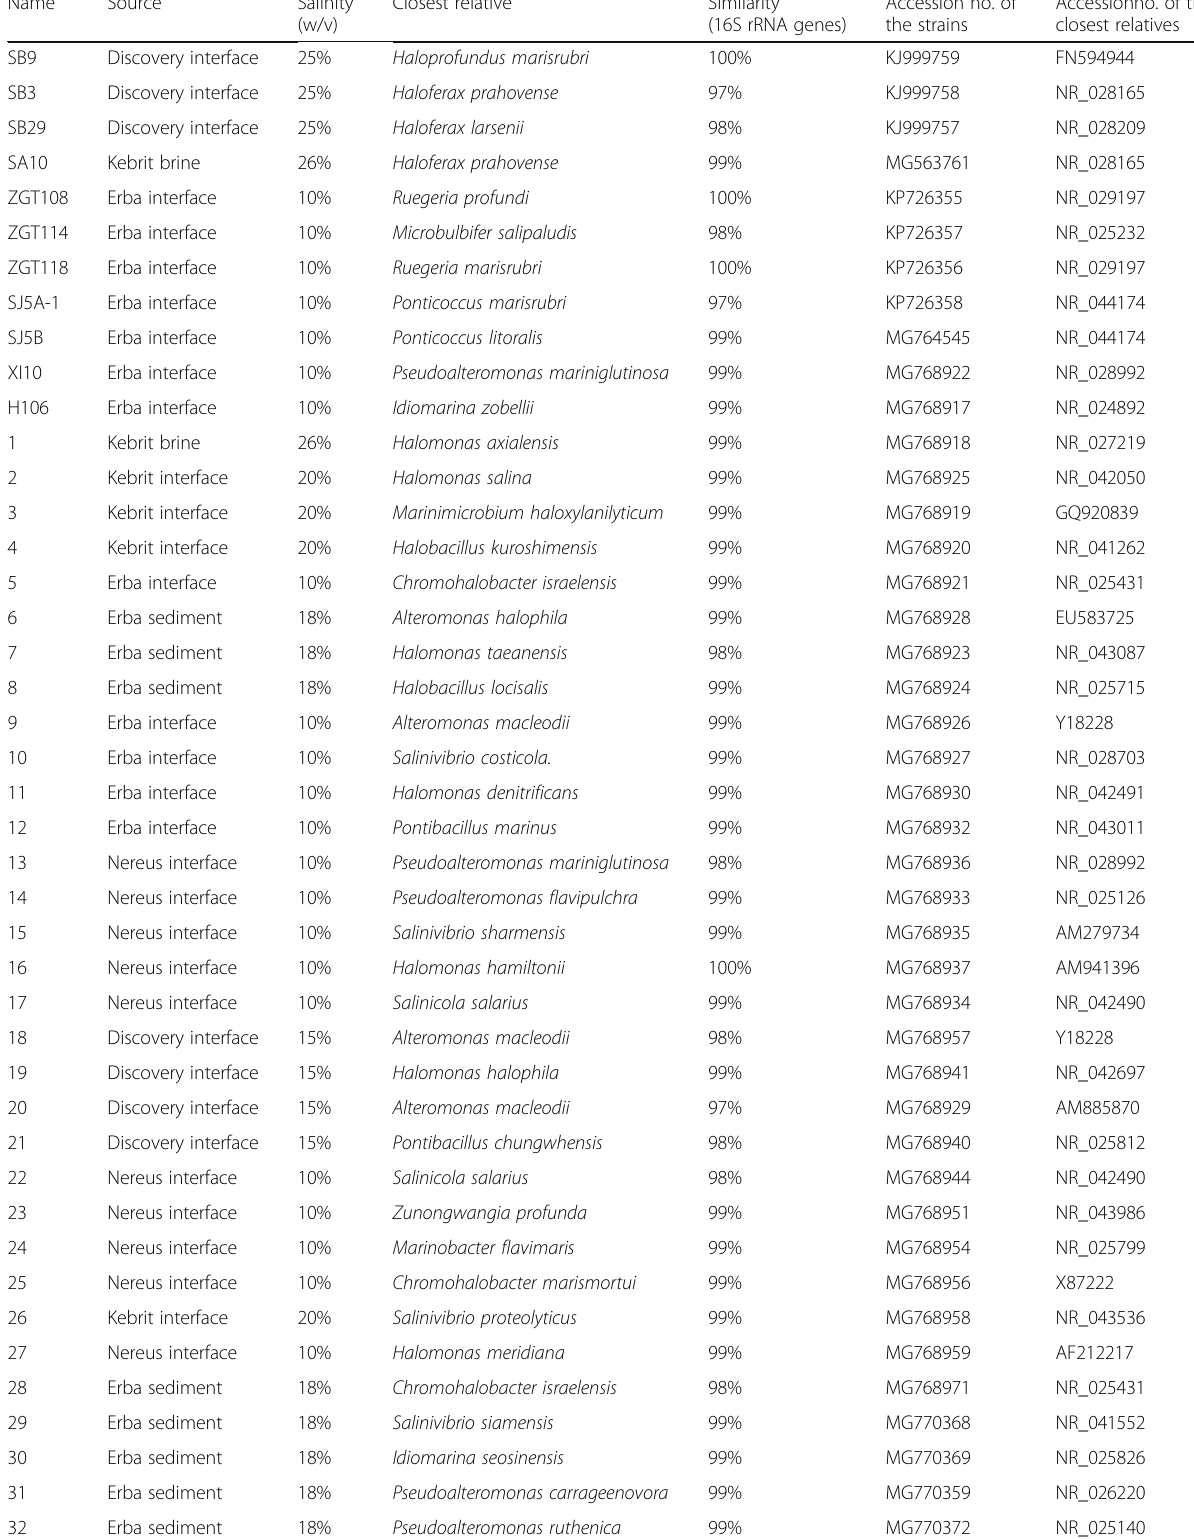
Table 1 Identification of microbial stains. Taxonomic identification based on 16S rRNA gene analysis and the source of inoculum for 60 microbial